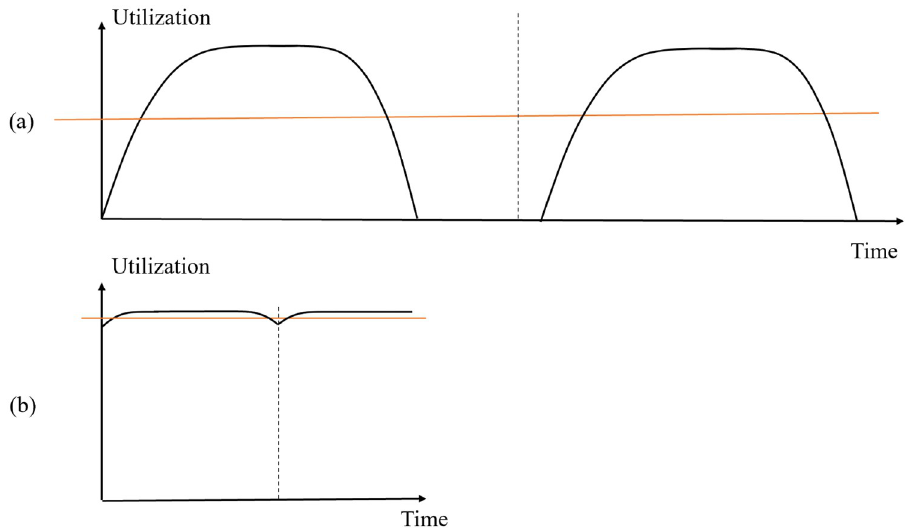
Fig 6. Utilization level without batch compensation (red line: Average utilization